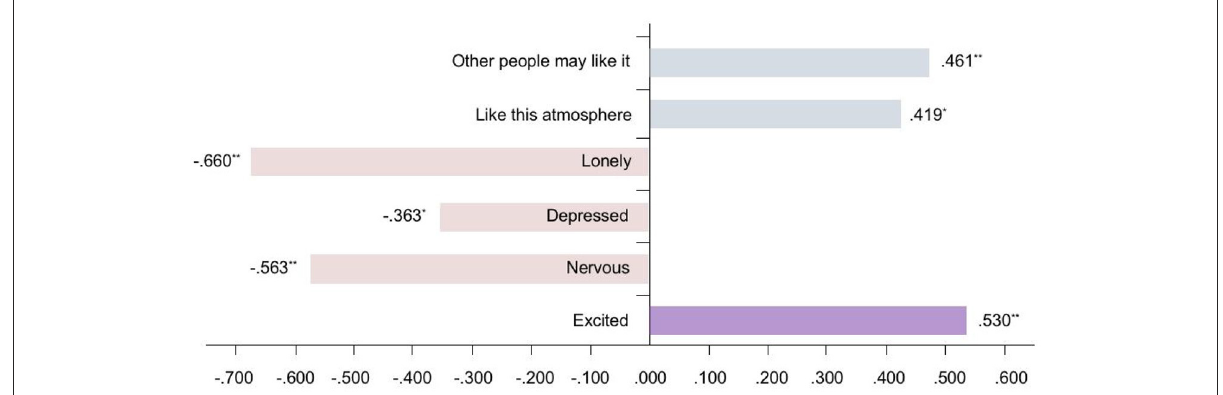
FIGURE8 Spearman correlation coefficients between the boring-interesting impression and mood.